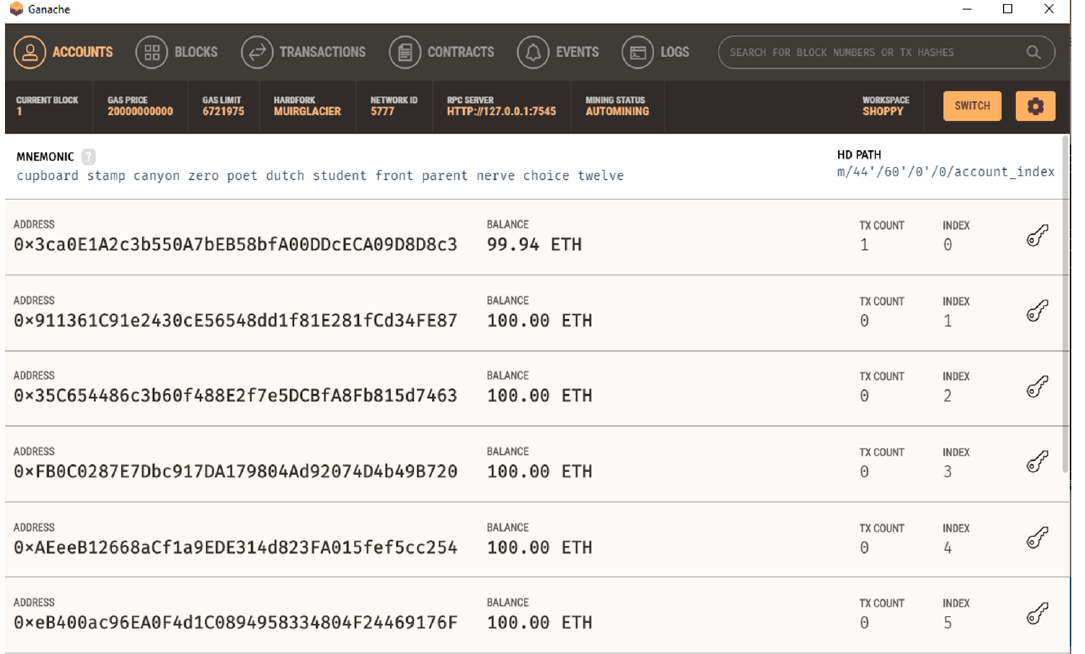
Figure 11. Ganache results example.